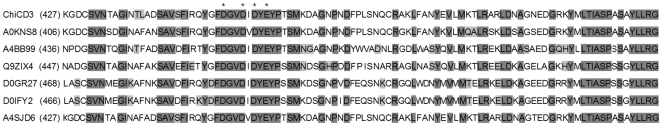
Amino acid sequence alignment of ChiCD3 with the chitinases by CLUSTAL.A0KNS8 from Aeromonas hydrophila subsp. hydrophila ATCC 7966, A4BB99 from Reinekea sp. MED297, Q9ZIX4 from Pseudoalteromonas sp. S9, D0GR27 from Vibrio mimicus MB-451, D0IFY2 from Vibrio sp. RC586 and A4SJD6 from Aeromona salmonicida subsp. salmonicida A449. The positions of the known catalytic residues in the chitinases are indicated by asterisks. Identical residues are boxed in black and conserved residues are boxed in gray.